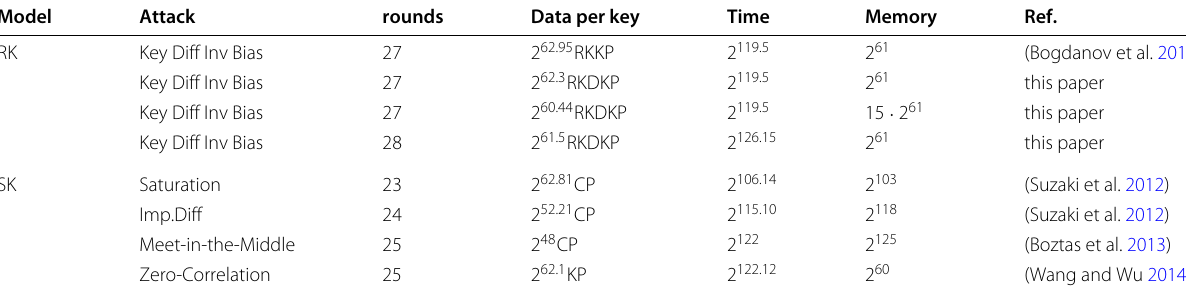
Table 2 Comparison of key-recovery attacks on TWINE-128